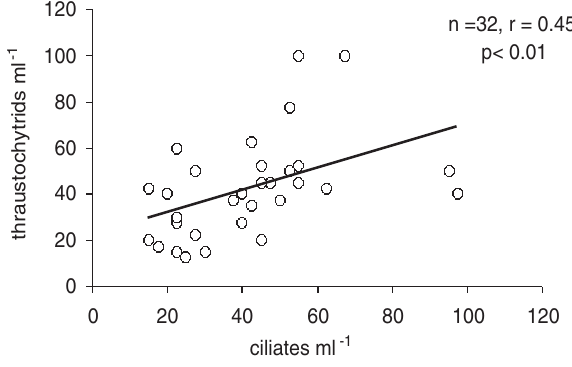
F IG . 3. – Relationship between the abundances of ciliates and thraustochytrids, y= 0.48 x +